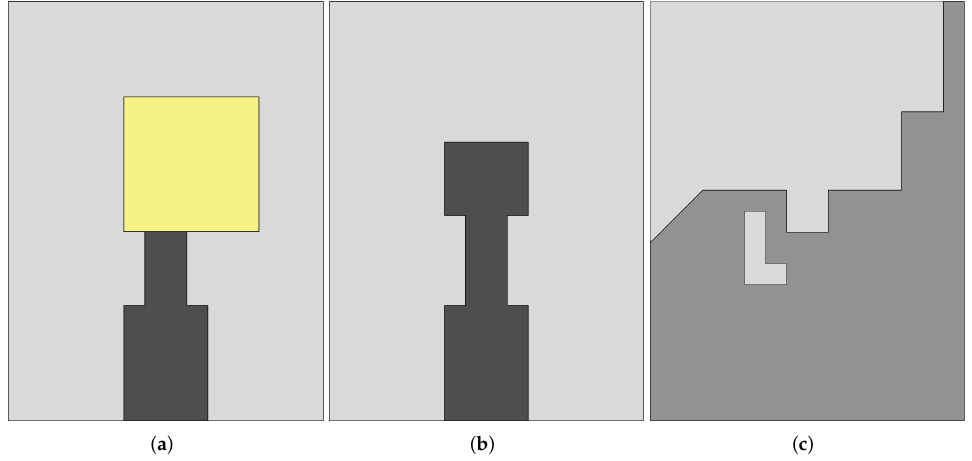
Figure 34. Design of a cubical shaped DRA ( a ) front-view ( b ) feed line ( c ) slotted ground plane (redrawn from [133]). Dark gray top metal face, medium gray bottom metal face, light gray dielectric substrate, and medium yellow DRA.